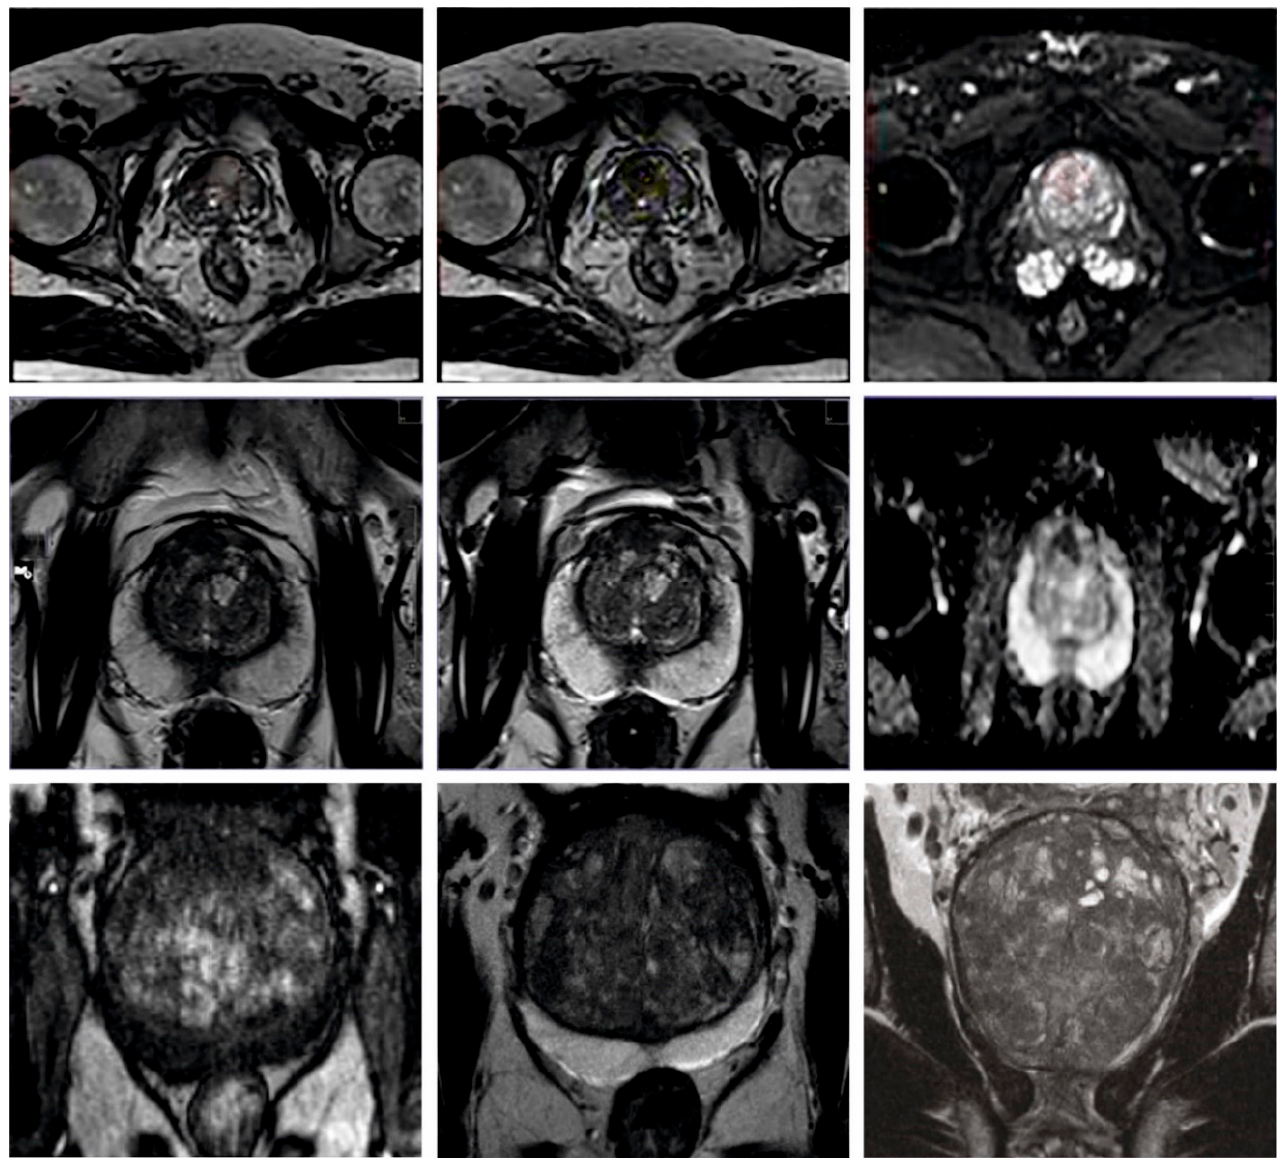
Figure 3. Sample images.